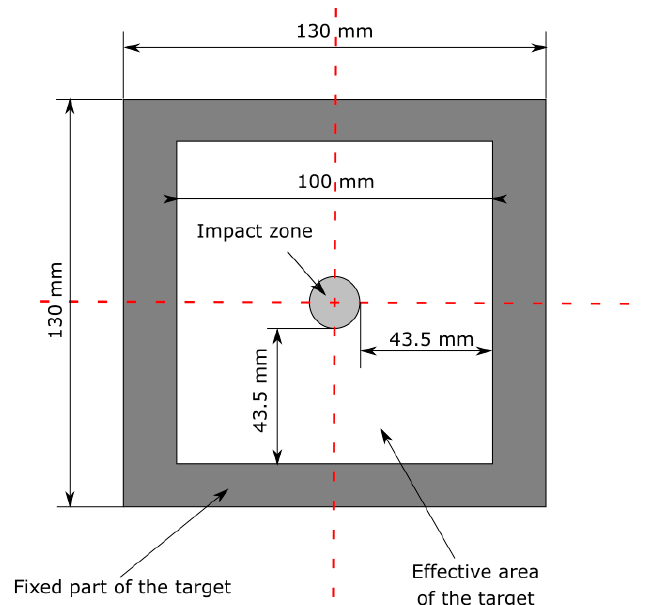
Figure 2. Geometry and dimensions of the target.